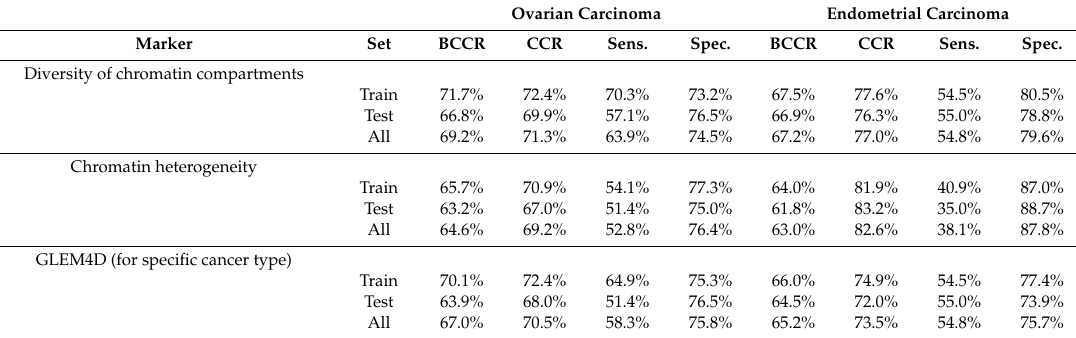
BCCR, balanced correct classification rate; CCR, correct classification rate; GLEM4D, four-dimensional grey level entropy